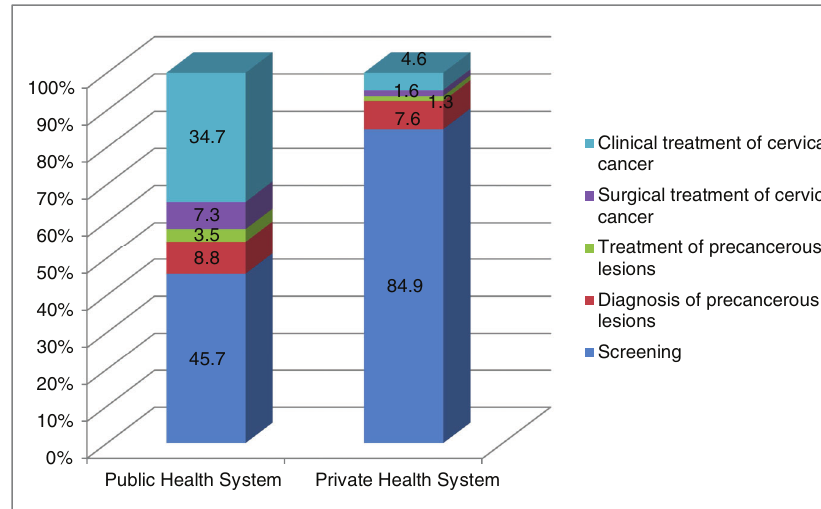
Figure 1 - Estimates costs distribution (%) by cervical cancer care components in Brazil,